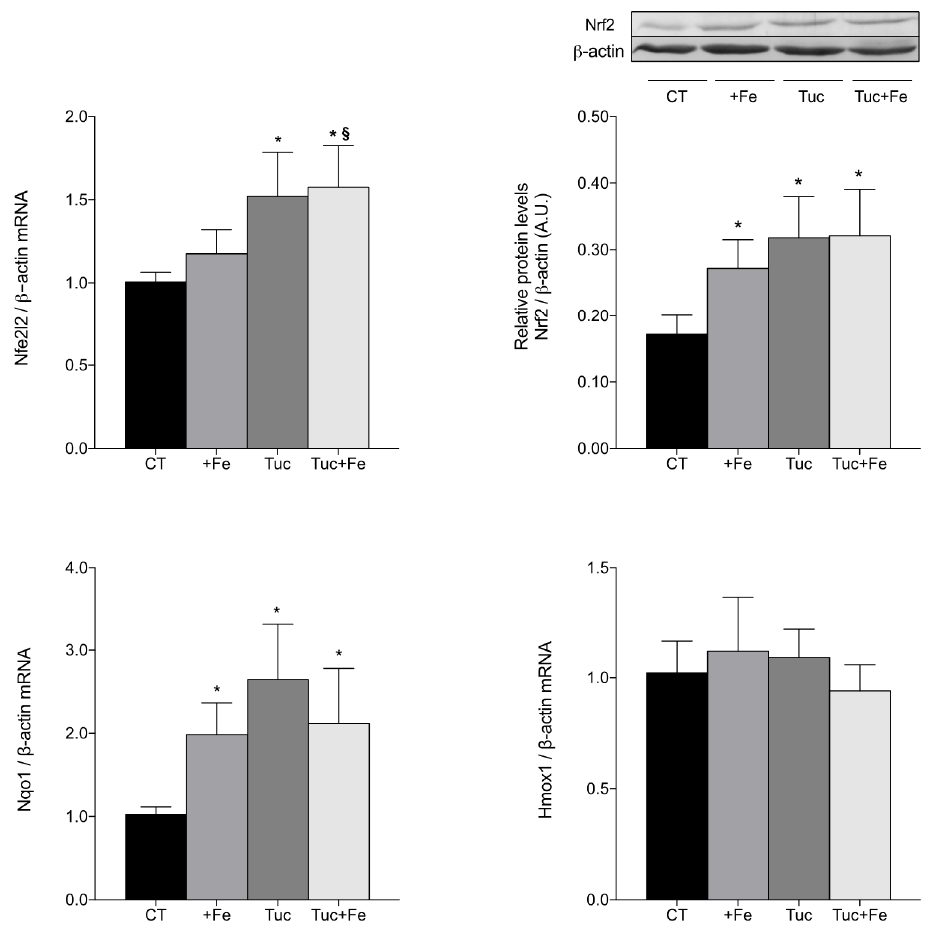
Figure 3. Hepatic mRNA levels quantification of nuclear factor erythroid 2-related factor 2 gene (Nfe2l2) and protein (Nrf2), NAD(P)H dehydrogenase quinone 1 (Nqo1) and heme-oxygenase 1 (Hmox1) mRNA levels of adult rats treated for 12 weeks. Data correspond to average ± standard deviation ( n = 6). * Statistical differences compared to CT group ( p < 0.05). § Statistical difference compared to +Fe group ( p < 0.05).